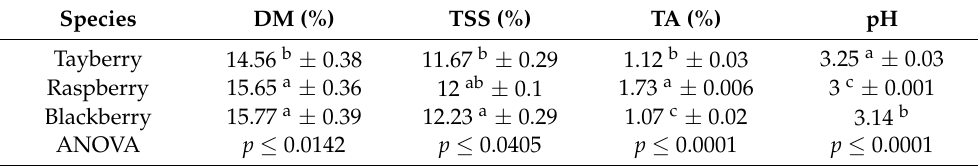
Table 2. Physico-chemical properties of fresh berry fruits.